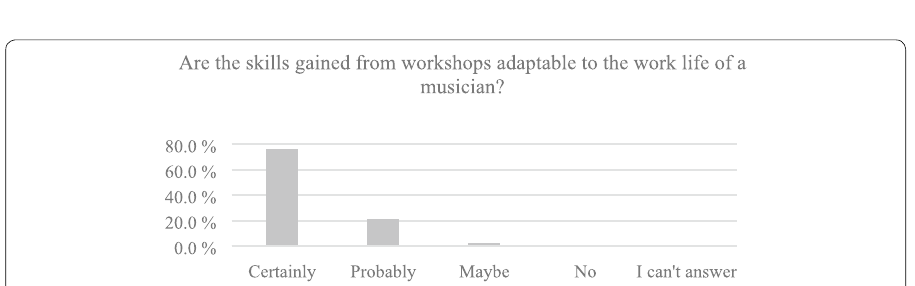
Fig. 3 The adaptability of the competence gained in workshops to a musician’s